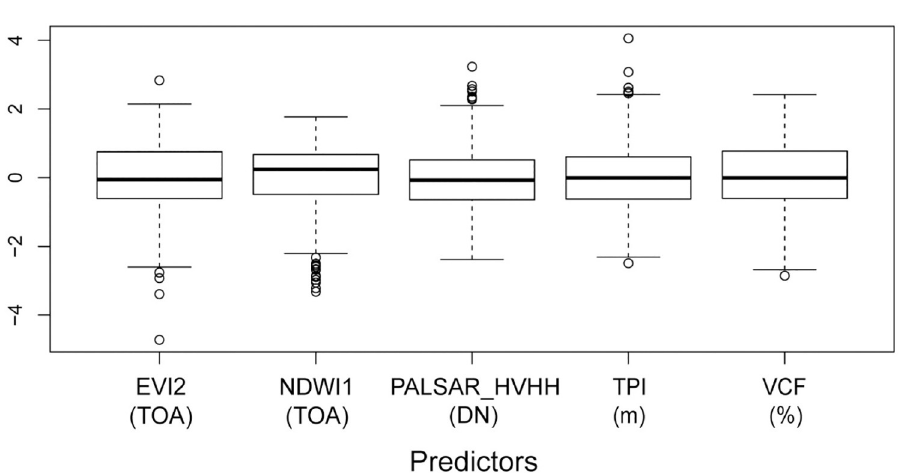
Fig 6. Boxplots of standardized uncorrelated predictors used for modeling. See Table 1 for predictor descriptions. Measurement units are indicated in parentheses. Unit abbrev.: DN, digital number; TOA, top-of-atmosphere